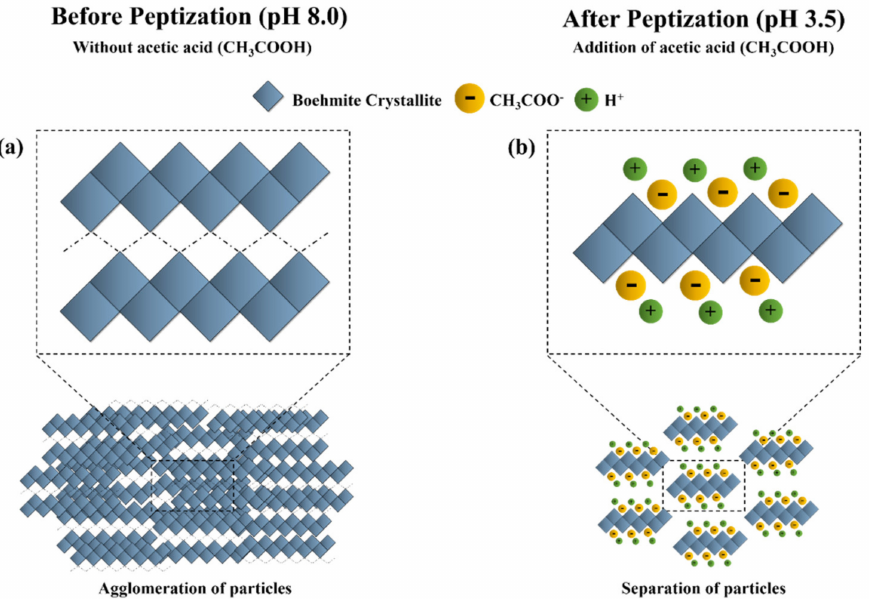
Figure 3. Schematic representation of the adsorption of acetic acid on boehmite crystals; ( a ) agglom- eration of boehmite crystal chains due to attractive forces among them without the addition of acetic acid, ( b ) separation of boehmite crystal chains due to repulsive forces induced by the addition of acetic